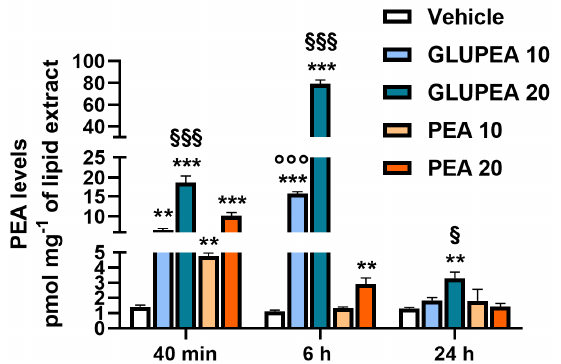
Figure 1. PEA levels in human keratinocyte (HaCaT) keratinocytes after glucuronic acid- palmitoylethanolamide conjugate (GLUPEA) treatment. PEA levels were measured in HaCaT keratinocytes treated for 40 min, 6 h, and 24 h with GLUPEA (10–20 µ M) or PEA (10–20 µ M). Data are representative of n = 8 separate determinations (means + s.e.m.). Statistical analyses were carried out using one-way ANOVA followed by the Newman–Keuls multiple comparison test (** p < 0.01, *** p < 0.001, versus vehicle; °°° p < 0.001 versus 10 μ M PEA; § p < 0.05, §§§ p < 0.001, versus 20 μ M PEA).